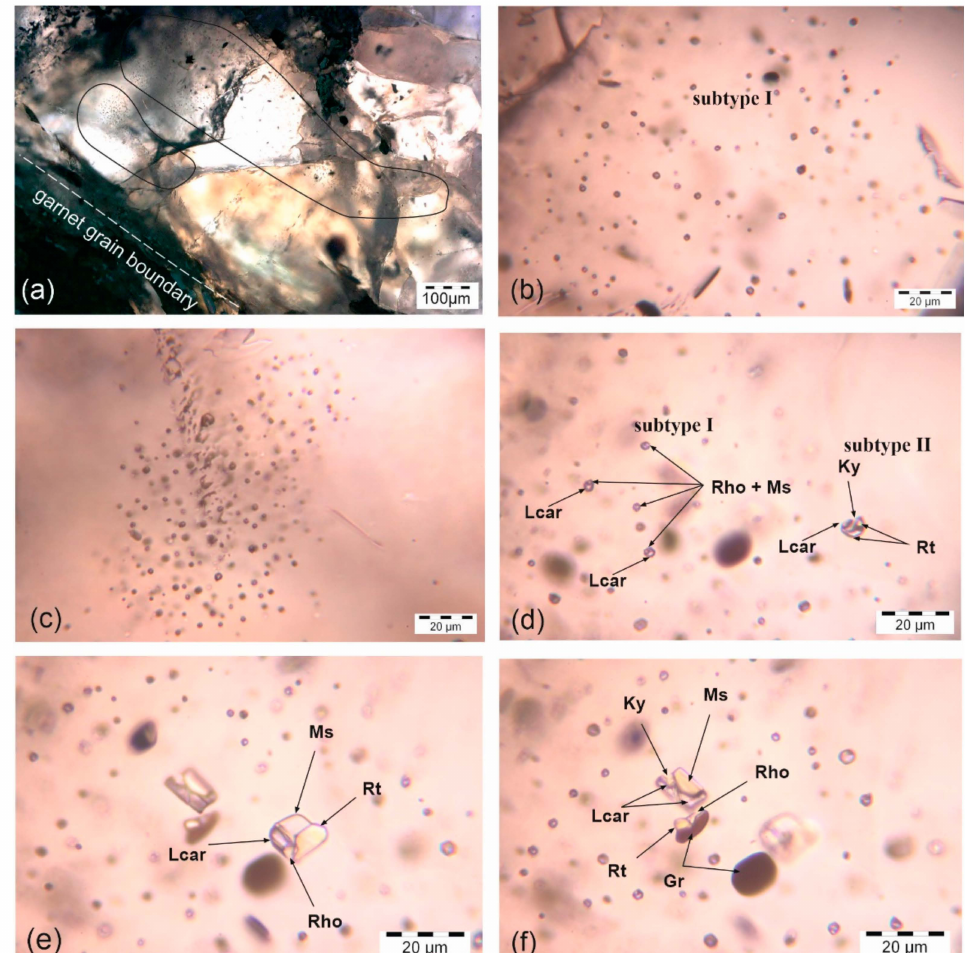
Figure 4. Representative fluid inclusion textures from a garnet core of sample Kor_3. Lcar: liquid carbonic phase; S: solid phase; abbreviations of solid phases after Whitney and Evans [25]. ( a ) Primary inclusion clusters of subtype I (inside the black frames) aligned parallel to the garnet grain boundary. ( b ) Details of a subtype I inclusion cluster. ( c ) Cluster of subtype I FIs cut by a late intragranular crack. ( d ) Textural relation between subtype I and II primary inclusions. Solid phases of subtype I (i.e., rhodochrosite and muscovite) and subtype II (i.e., kyanite and rutile). All solids were surrounded by carbonic liquid (Lcar). ( e ) Details and phase characterization of a subtype II inclusion. ( f ) Details of a subtype II showing the coeval presence of Lcar and graphite-bearing inclusions together with solids kyanite, muscovite, rhodochrosite, and